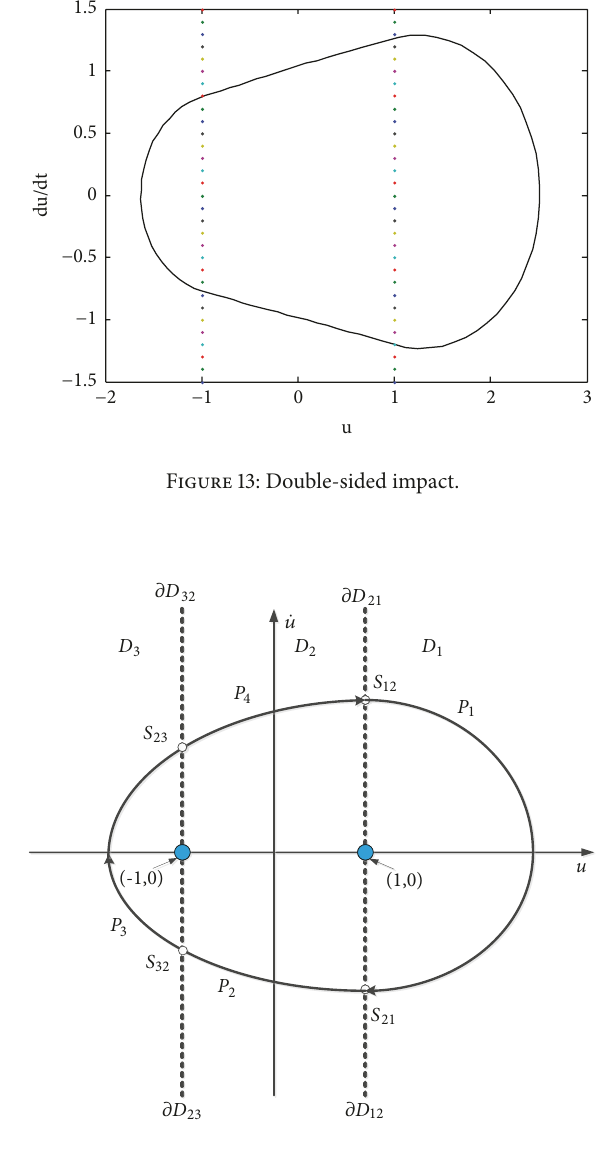
Figure 14: The mapping